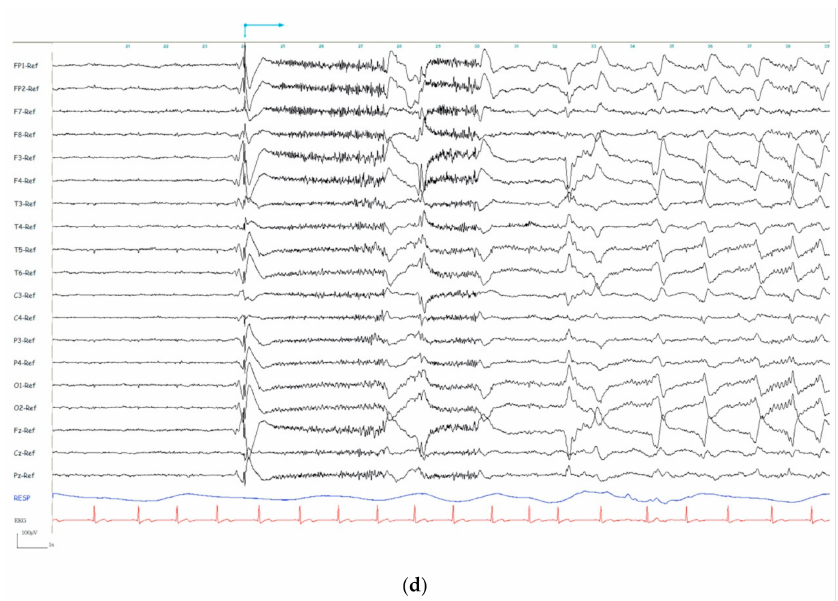
Figure 3. ( a ) Seizure onset patterns: Rhythmic ictal discharge of >20 µ V. ( b ) Seizure onset patterns: Low amplitude ictal beta rhythm (<20 µ V). ( c ) Seizure onset patterns: Global attenuation (<10 µ V). ( d ) Seizure onset patterns: Interictal epileptiform discharge (IED) just prior to the ictal